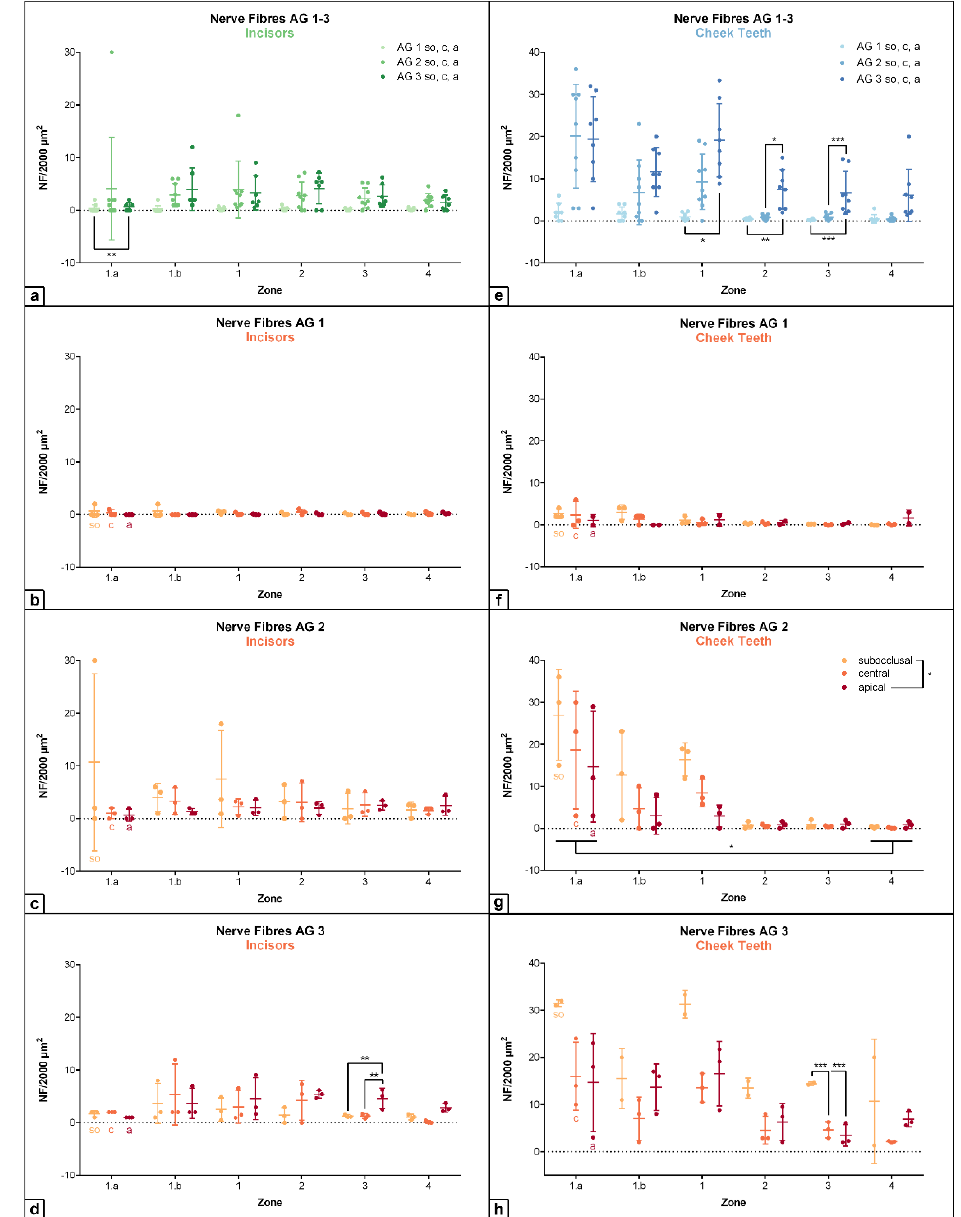
Figure 4. Dot-plot diagram showing the density of nerve fibers (number per 2000 µ m 2 ) of different age groups (AG 1 to 3) within different zones (zone 1.a to 4). The horizontal levels subocclusal ( so ), central ( c ) and apical ( a ) are shown within the different age groups. Mean was presented as a central horizontal bar and the standard deviation as vertical whiskers. p -values: p ≤ 0.05 (*), p ≤ 0.01 (**), and p ≤ 0.001 (***). ( a ) Dot-plot diagram showing the density of nerve fibers in incisors of AG 1, AG 2 and AG 3 (green colors). Horizontal levels ( so , c , a ) are combined within each age group. ( b ) Dot-plot diagram showing the density of nerve fibers in incisors of AG 1 (orange colors). ( c ) Dot-plot diagram showing the density of nerve fibers in incisors of AG 2 (orange colors). ( d ) Dot-plot diagram showing the density of nerve fibers in incisors of AG 3 (orange colors). ( e ) Dot-plot diagram showing the density of nerve fibers in cheek teeth of AG 1, AG 2, and AG 3 (blue colors). Horizontal levels ( so , c , a ) are combined within each age group. ( f ) Dot-plot diagram showing the density of nerve fibers in cheek teeth of AG 1 (orange colors). ( g ) Dot-plot diagram showing the density of nerve fibers in cheek teeth of AG 2 (orange colors). ( h ) Dot-plot diagram showing the density of nerve fibers in cheek teeth of AG 3 (orange colors).